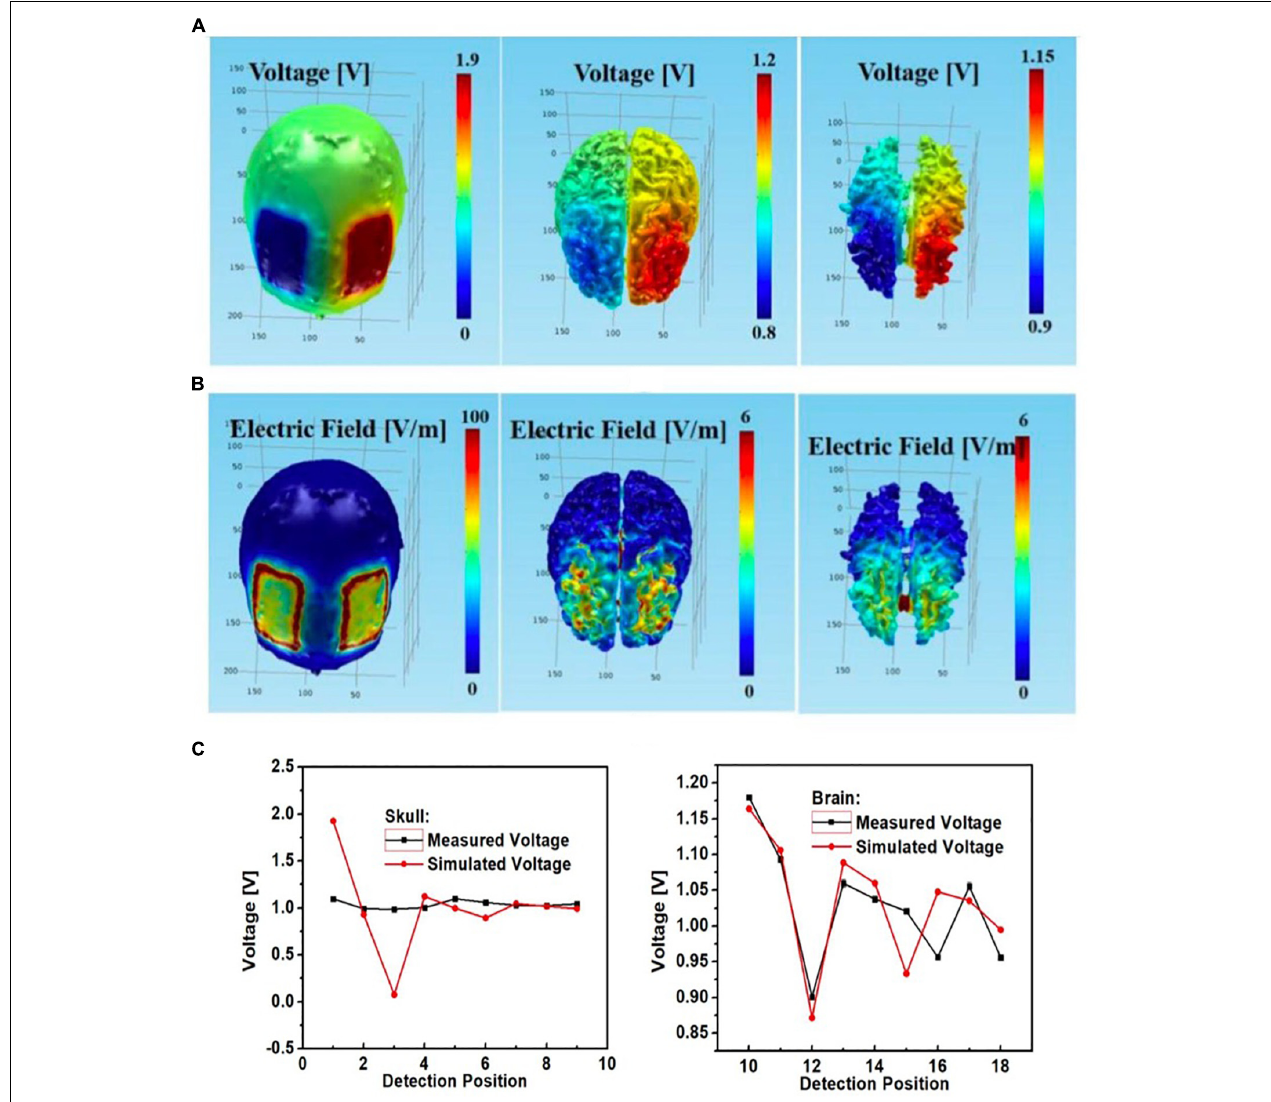
FIGURE 10 | Bilateral DLPFC montage with anode over the left DLPFC, cathode over the right DLPFC using rectangular pads as the stimulation electrodes; simulated (A) electric potential and (B) electric field in skull (left), gray matter (middle) and white matter (right); (C) simulated and measured voltages at the nine monitoring electrodes in the skull (left) and brain (right)